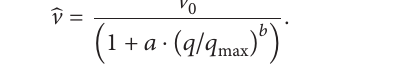
̂𝑡 : theoretical travel time computed with VDF